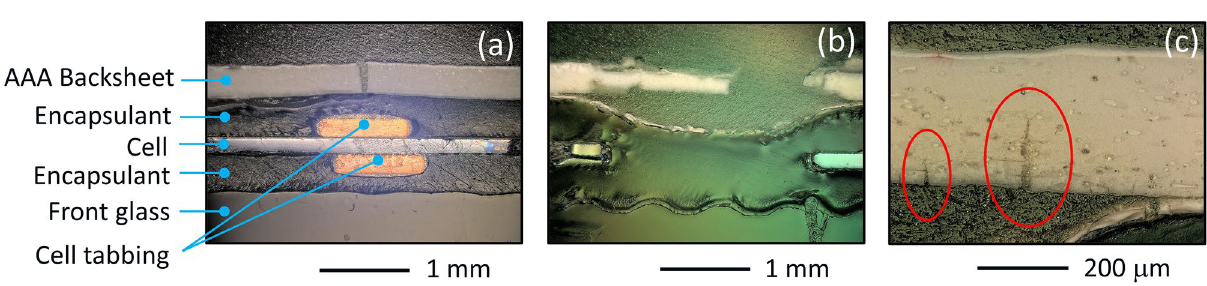
Figure 2. ( a ) X-ray transmission image (normal to the surface) and ( b ) a cross-sectional micrograph of the as received backsheet showing the glass fiber filler present in the core layer.